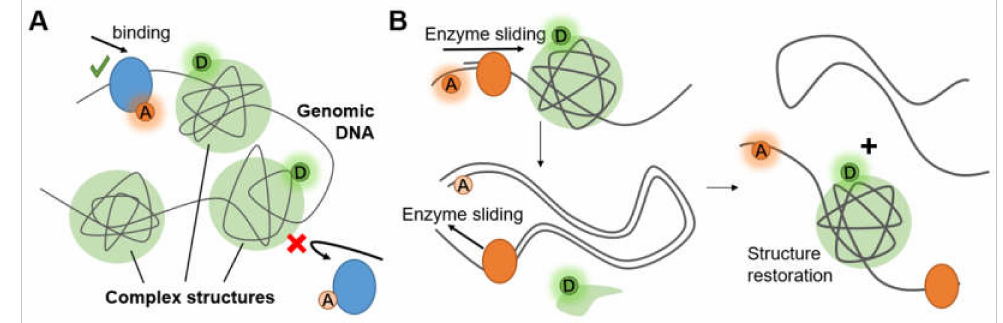
Figure 7. ( A ) Complex structures on chromosomes alter accessibility. ( B ) Complex structure restored after being destroyed by enzyme